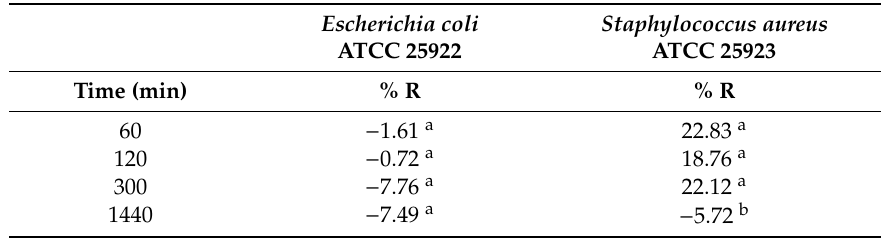
Table 1. Percent reduction (% R ) of Escherichia coli and Staphylococcus aureus at intervals of contact with the PVB / MAG 10 nanofibrous membrane related to neat